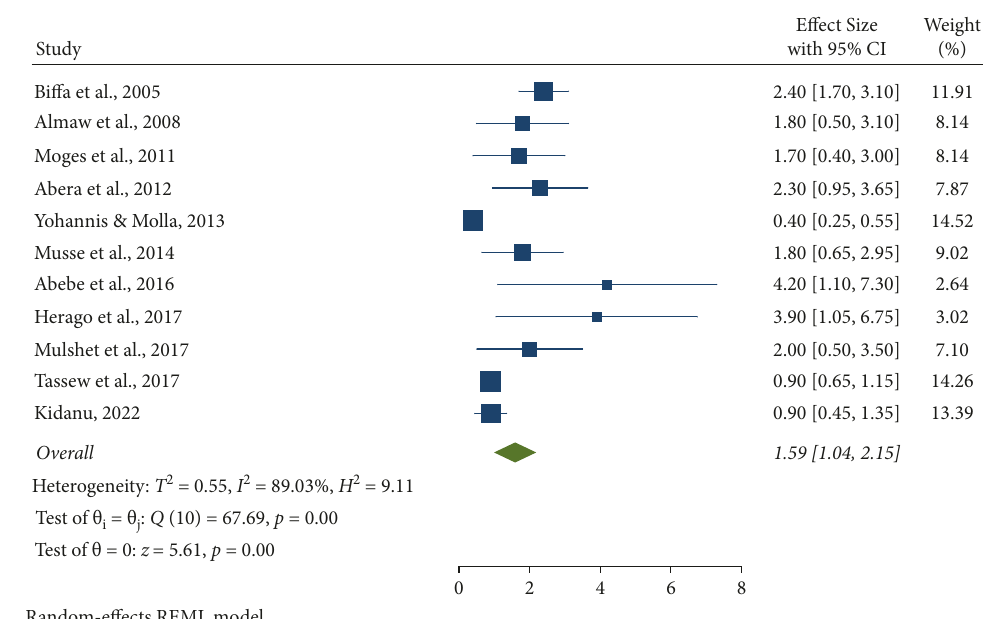
Figure 10: Lactation stage as an associated risk factor for mastitis among dairy